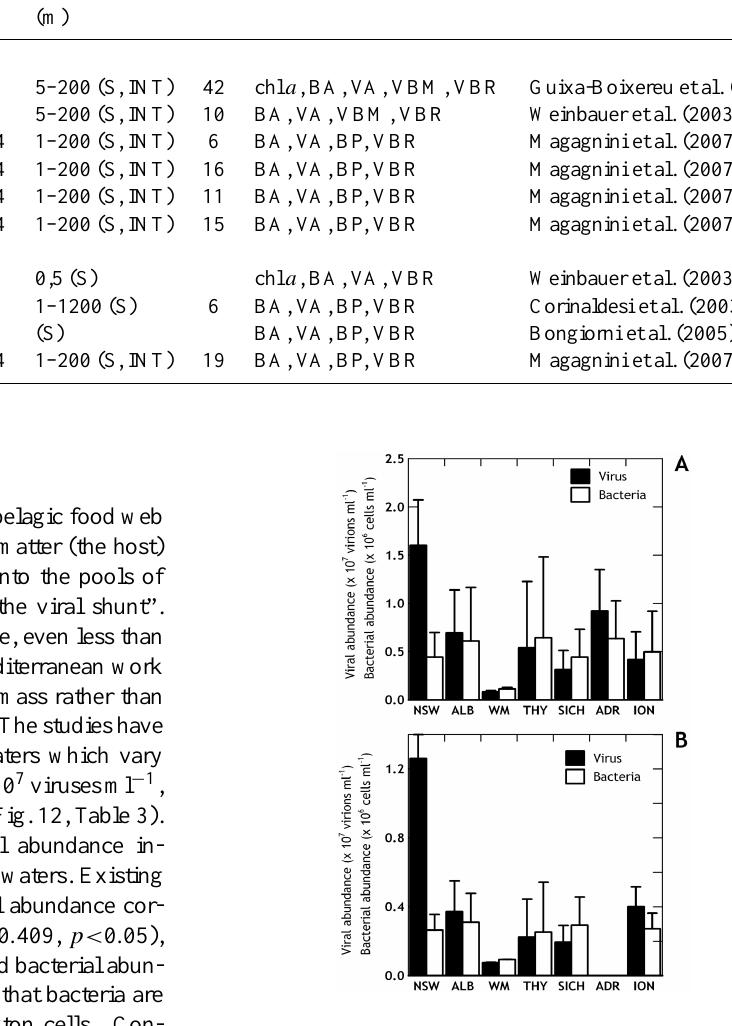
Fig. 12. Average surface viral and bacterial abundance from the dif- ferent Mediterranean sites (A) , average integrated values (1–200m), that were normalized in each case dividing them by the maximal considered depth (B) . Bars are SD of the mean. NWM: NW-MS, ALB: Alboran, WM: WMS, THY: Tyrrhenian, SICH: Straits of Sicily, ADR: Adriatic, ION: Ionian